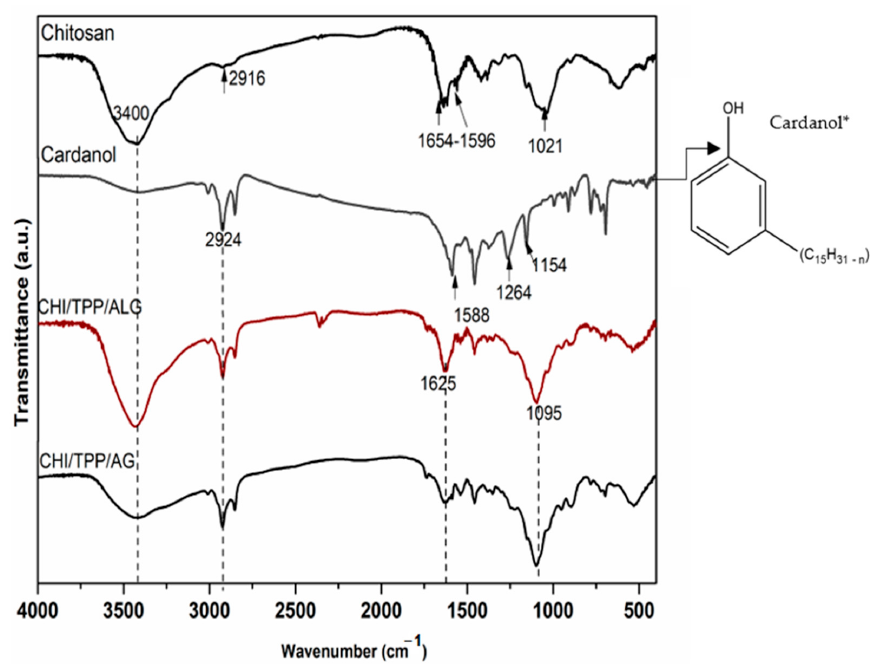
Figure 3. Spectra were obtained in the infrared region for samples of Chitosan, Cardanol* (CHI/TPP/ALG, and CHI/TP/AG).